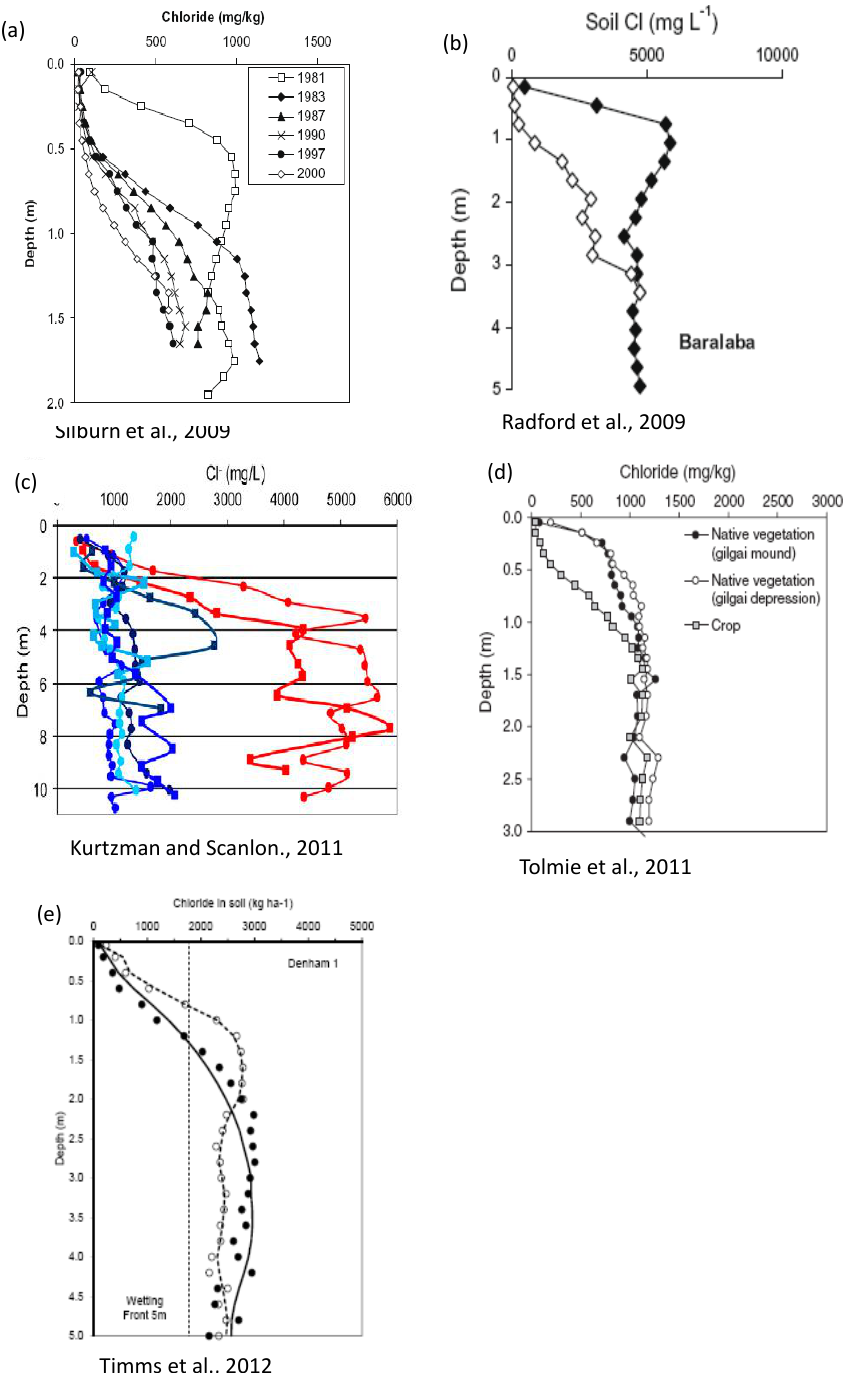
Figure 3. Flushing of chloride down through the unsaturated zone under cultivated vertisols: (a) Silburn et al. (2009) – 19 years of flushing; (b) Radford et al. (2009) – full diamond, native vegetation; empty, annual cropping; flushing from the top 3m (c) Kurtzman and Scan- lon (2011) – red, natural land; blue, irrigated cropping; flushing from 2–10m depth; (d) Tolmie et al. (2011) – flushing from the top 1.5m. (e) Timms et al. (2012) – black, cropping; empty – grass; flushing from the top 2m.